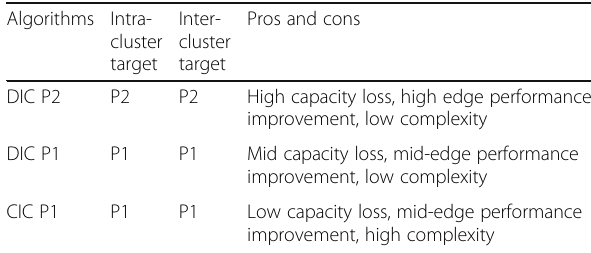
Table 2 Proposed algorithms Algorithms Intra- cluster